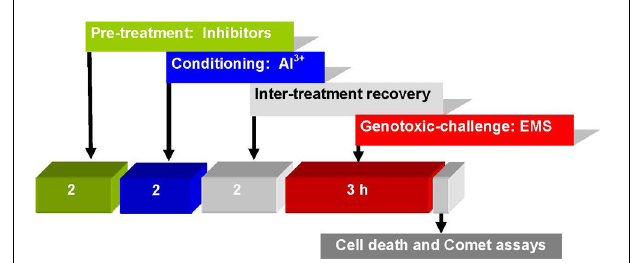
FIGURE 3 | Cell death and DNA damage in root cells of A. cepa visualized by Evans Blue staining and Comet assay in Control (A) and Al 800 µ M (B), respectively. Nuclei isolated from elongation and differentiation zones were analyzed for DNA damage by Comet